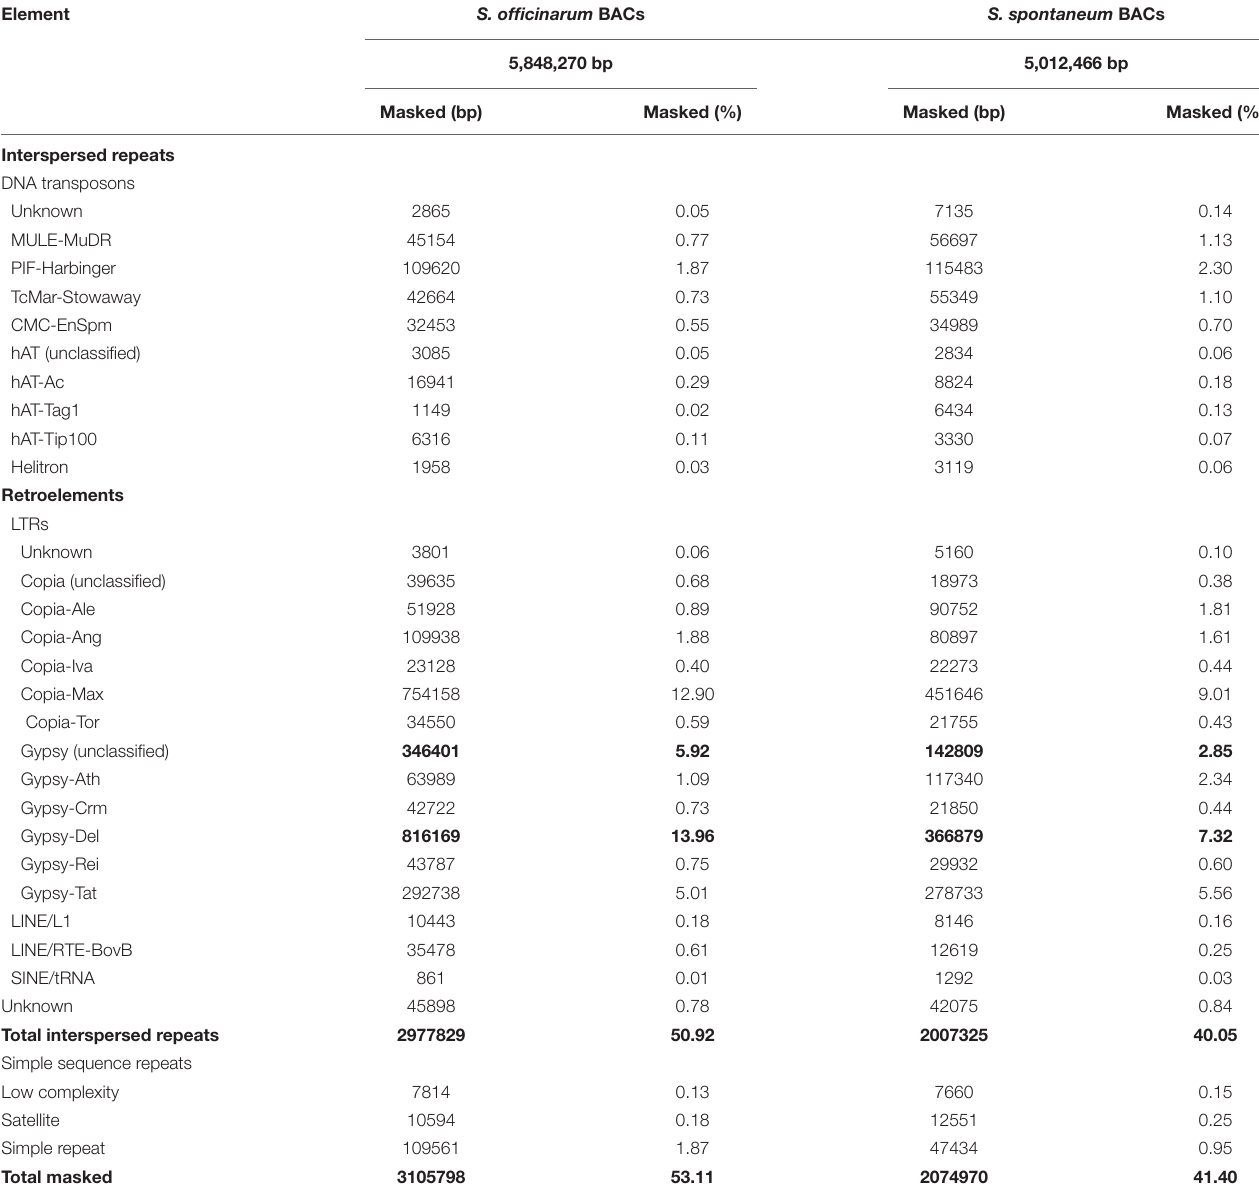
TABLE 1 | Summary of repeat content of Saccharum officinarum and Saccharum spontaneum BACs.